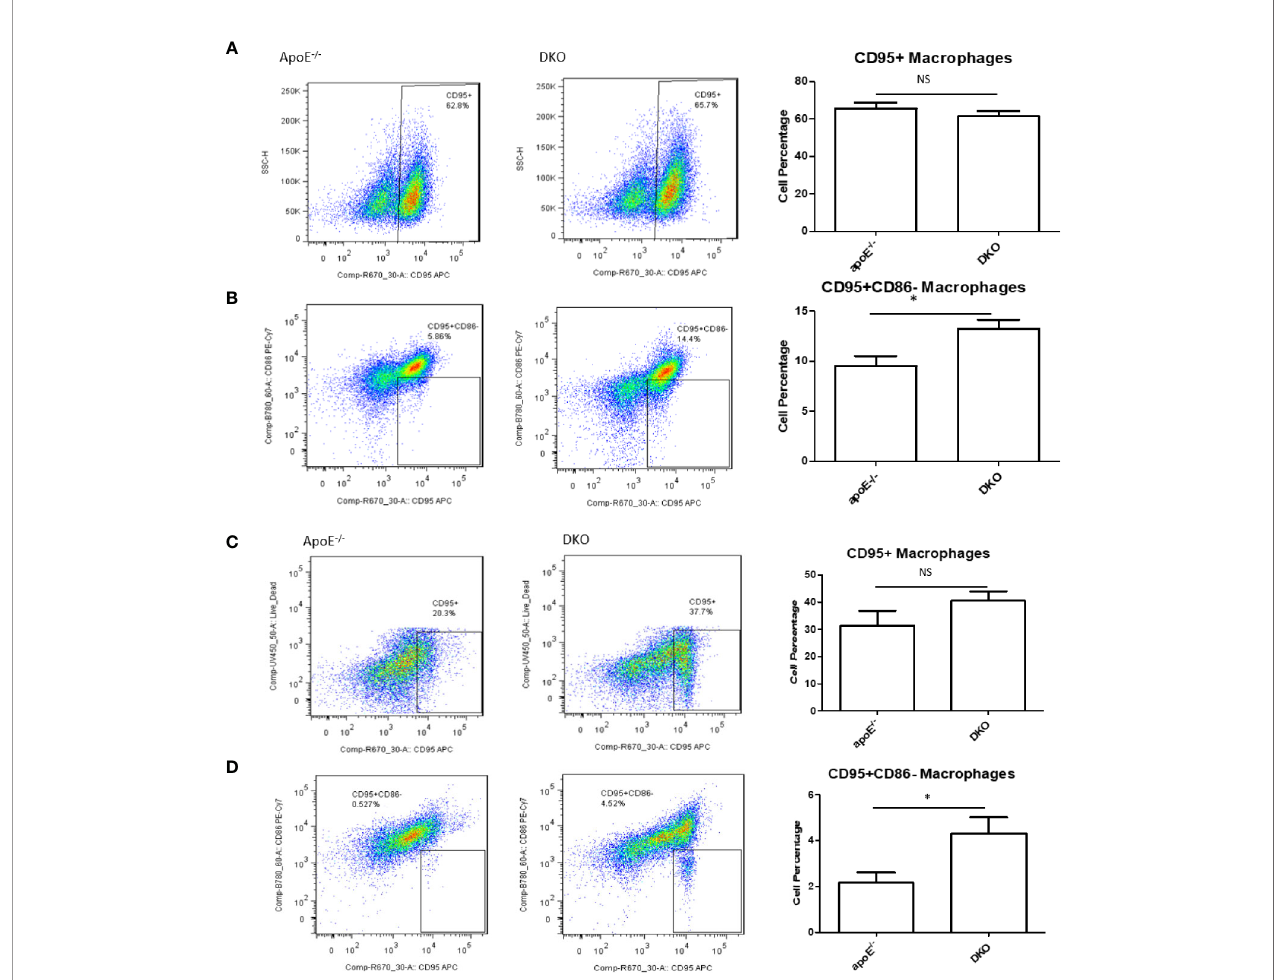
FIGURE 5 | A novel subset of CD95 + CD86 - macrophages is increased in the white adipose tissues of DKO versus that of ApoE -/- mice on high-fat diet. Mice were fed on HFD from 8 weeks old to 20 weeks old. Macrophages were de fi ned as CD45 + F4/80 + and then evaluated for the markers, CD95 and CD86. (A, B) Male mice: ApoE -/- (n=5), DKO (n=4). (C, D) Female mice: ApoE -/- (n=5), DKO (n=4). * p <0.05. NS, not signi fi